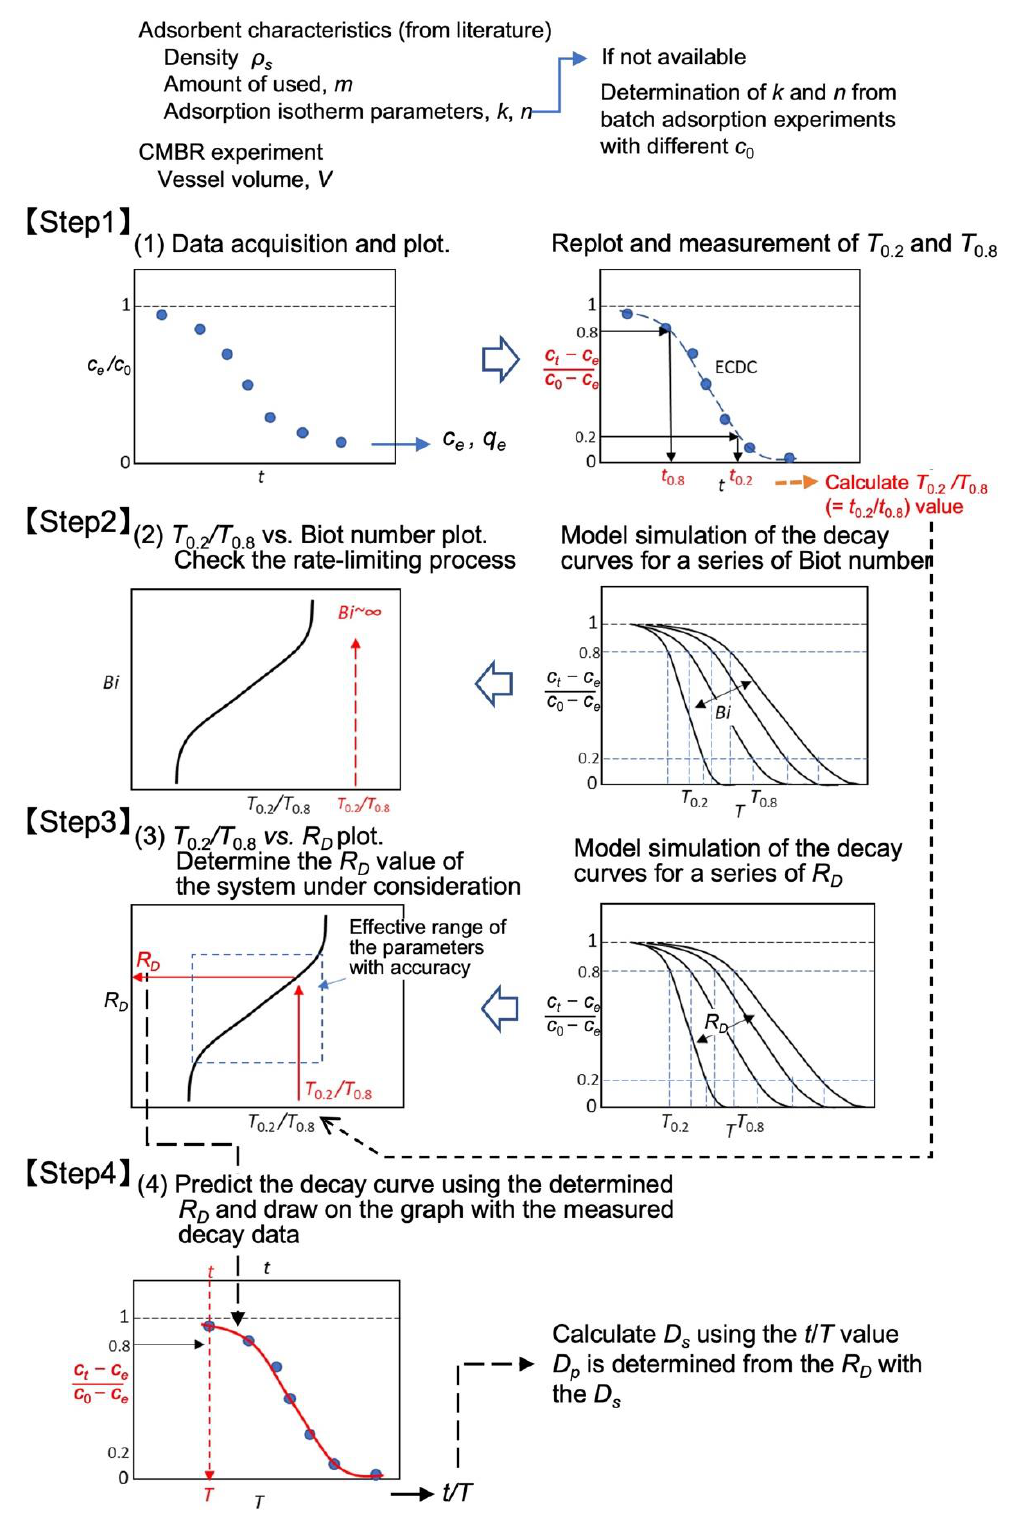
Figure 10. Determination procedure for the kinetic parameters.